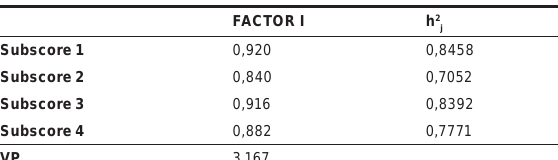
TAbLE 5 Factor matrix (full scale)